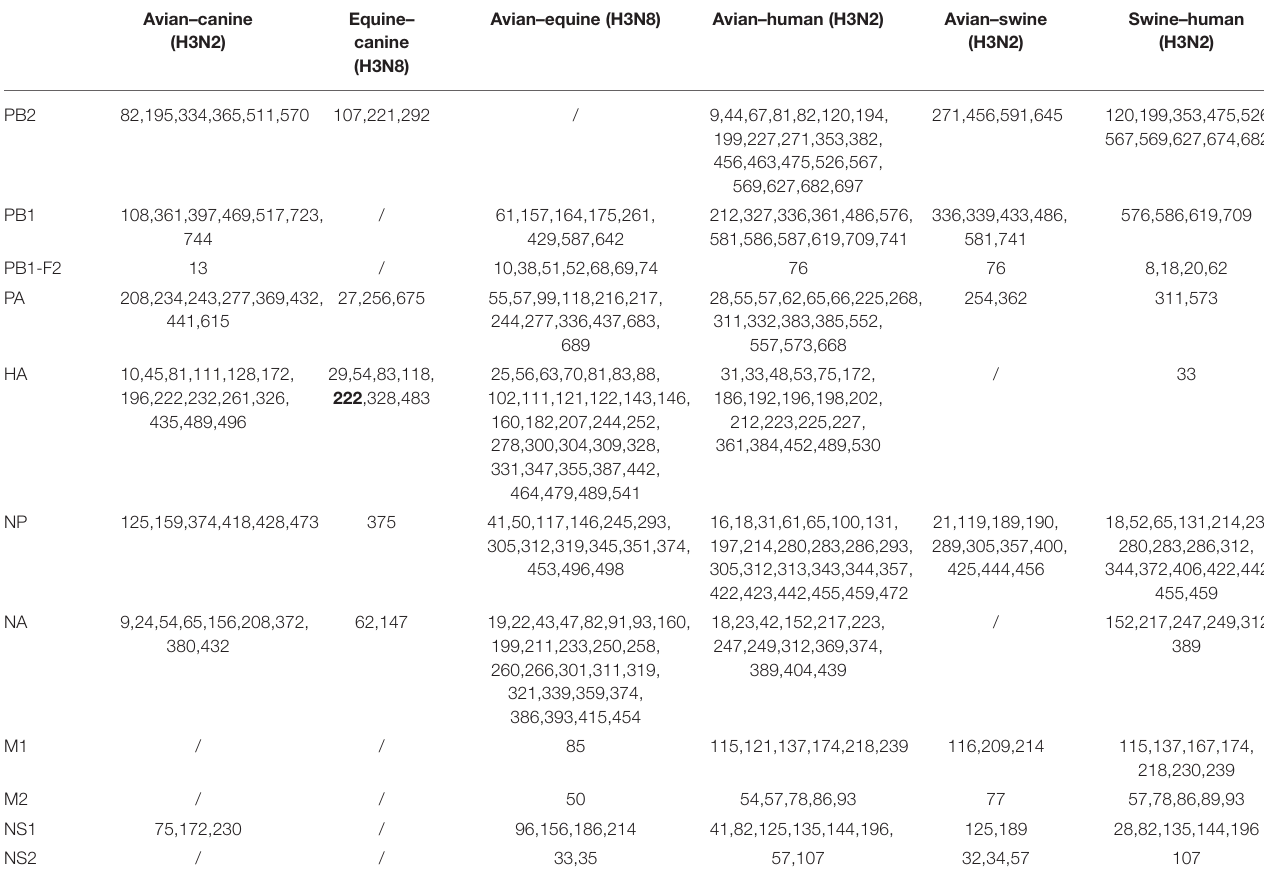
TABLE 2 | The positions of adaptive amino acid substitutions in different host-pair